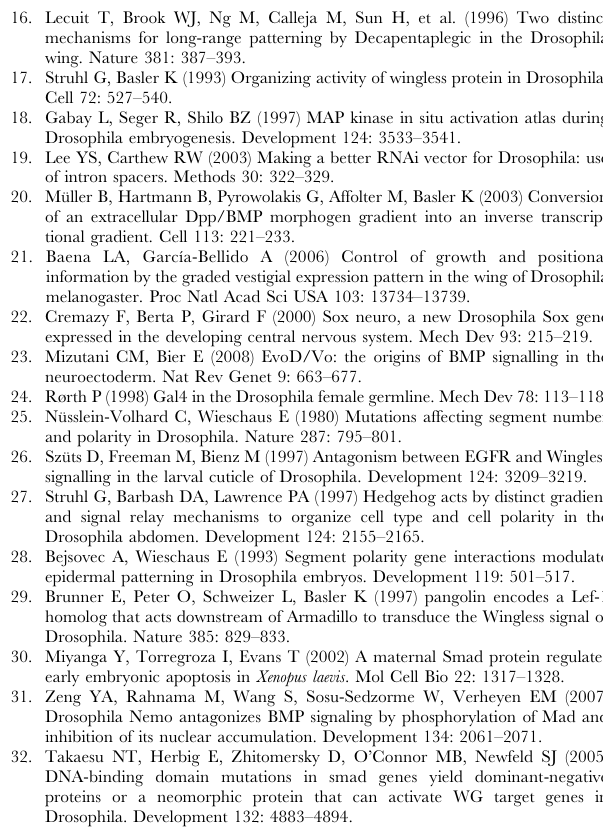
Figure S12 GSK3-resistant Activated Forms of Smad1 Disrupt Segmentation in Xenopus Embryos. (A and B) Immunostainings for myosin light chain showing loss of segmental borders in somites in the injected side (B) of a Xenopus embryo (stage 26), compared to the uninjected side. C2 or C3 blastomeres were injected with 100 pg of hSmad1 resistant to GSK3 phosphorylation [5] and 50 pg of nuclear LacZ mRNA (n= 32/42). (C–F) In situ hybridizations for the somite marker MyoD shows a disruption of the segmental pattern in Xenopus embryos (stage 30)